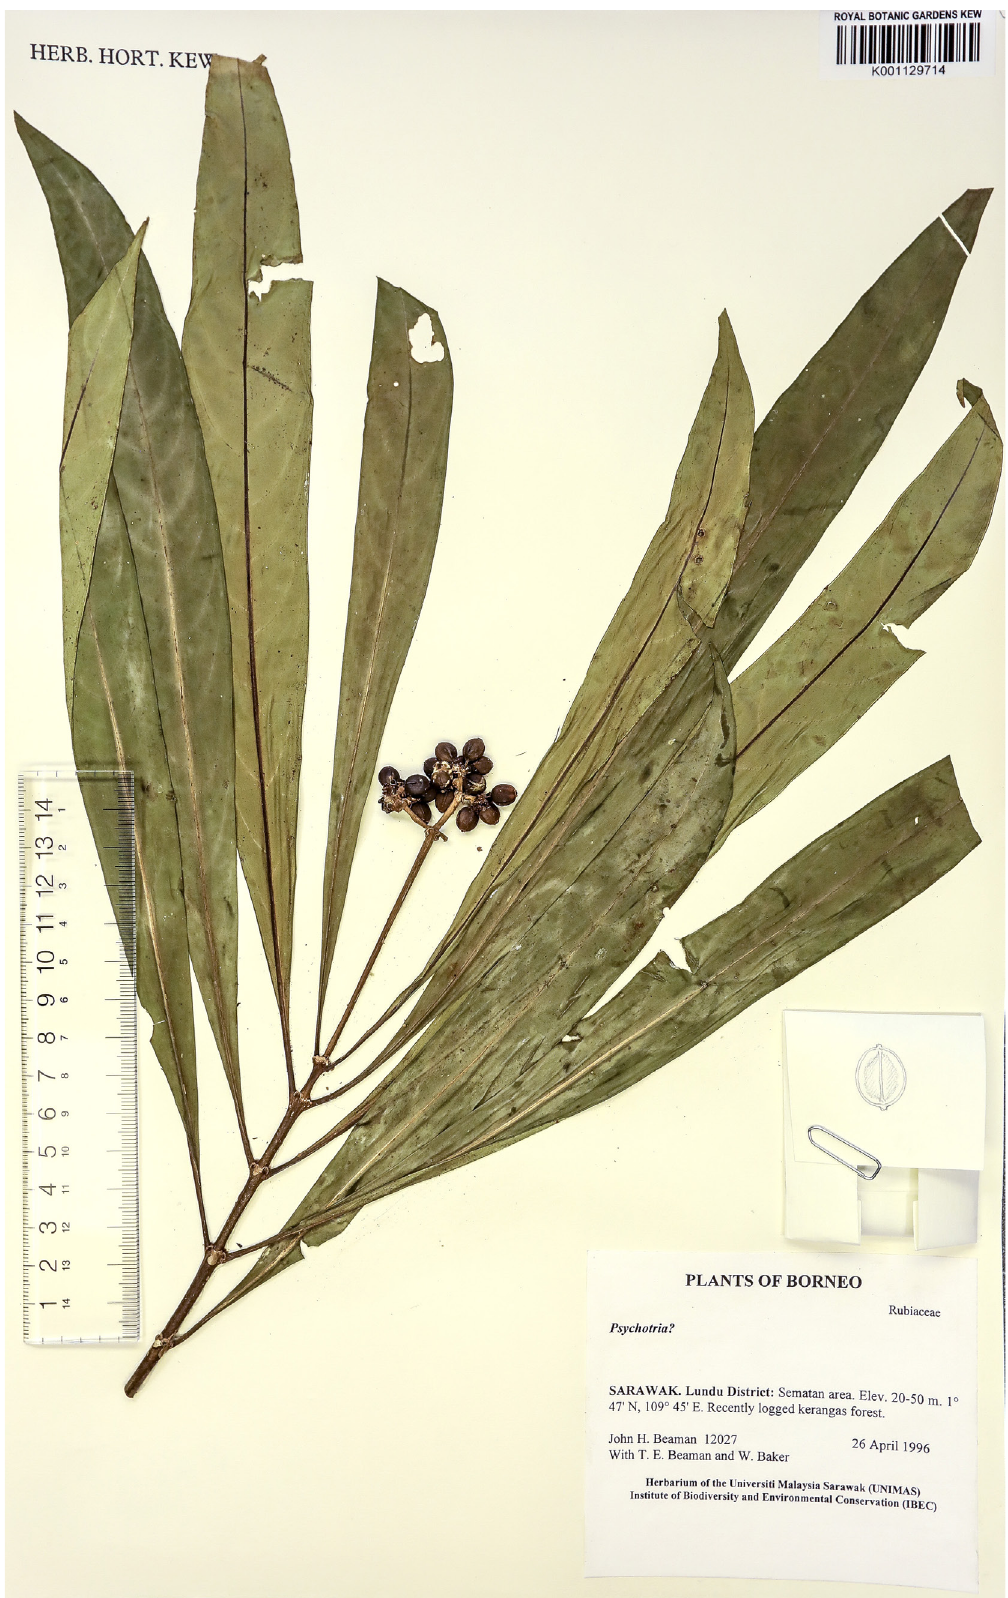
Fig. 19. Holotype of Chassalia lancifolioides T.Y.Yu sp. nov. ( John H. Beaman 12027